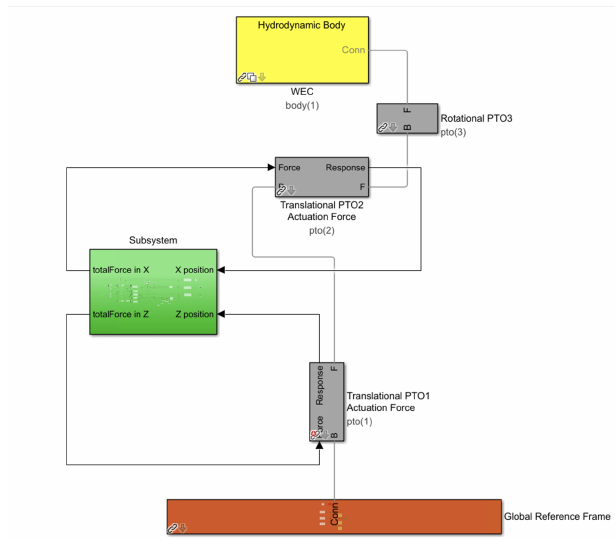
Fig. 4. WEC-Sim Simulink model of the Uppsala University